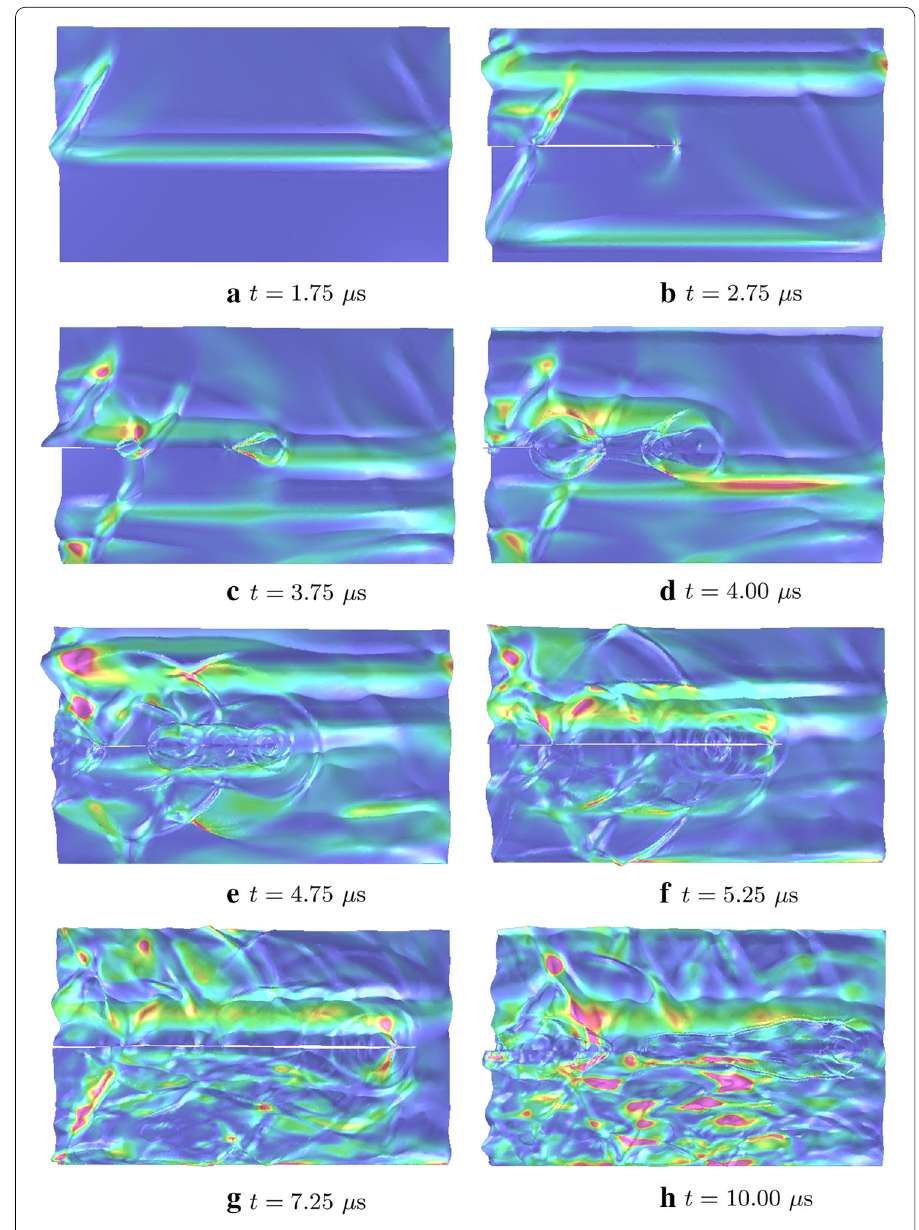
Fig. 4 Solution visualizations for planar fracture problem with crack closure and cyclic far-field loading Fracture and crack closure on a nonplanar bimaterial interface under cyclic loading This example demonstrates our model’s ability to simulate mixed-mode debonding and general interface state transitions on a nonplanar, bi-material interface between circu- lar inclusions and the surrounding matrix material. The computational domain is a 4 mm × 4 mm square comprised of matrix material and a stiff, circular inclusion with a 1 mm radius that is centered in the square domain. The matrix material proper- ties are Young’s modulus, E = 3 . 24 GPa; Poisson’s ratio, ν = 0 . 35; and mass density, ρ = 1190 kg / m 3 . The inclusion has the same elastic properties, except E = 32 . 4 GPa. Accordingly, the inclusion wave speeds exceed those in the matrix by a factor of